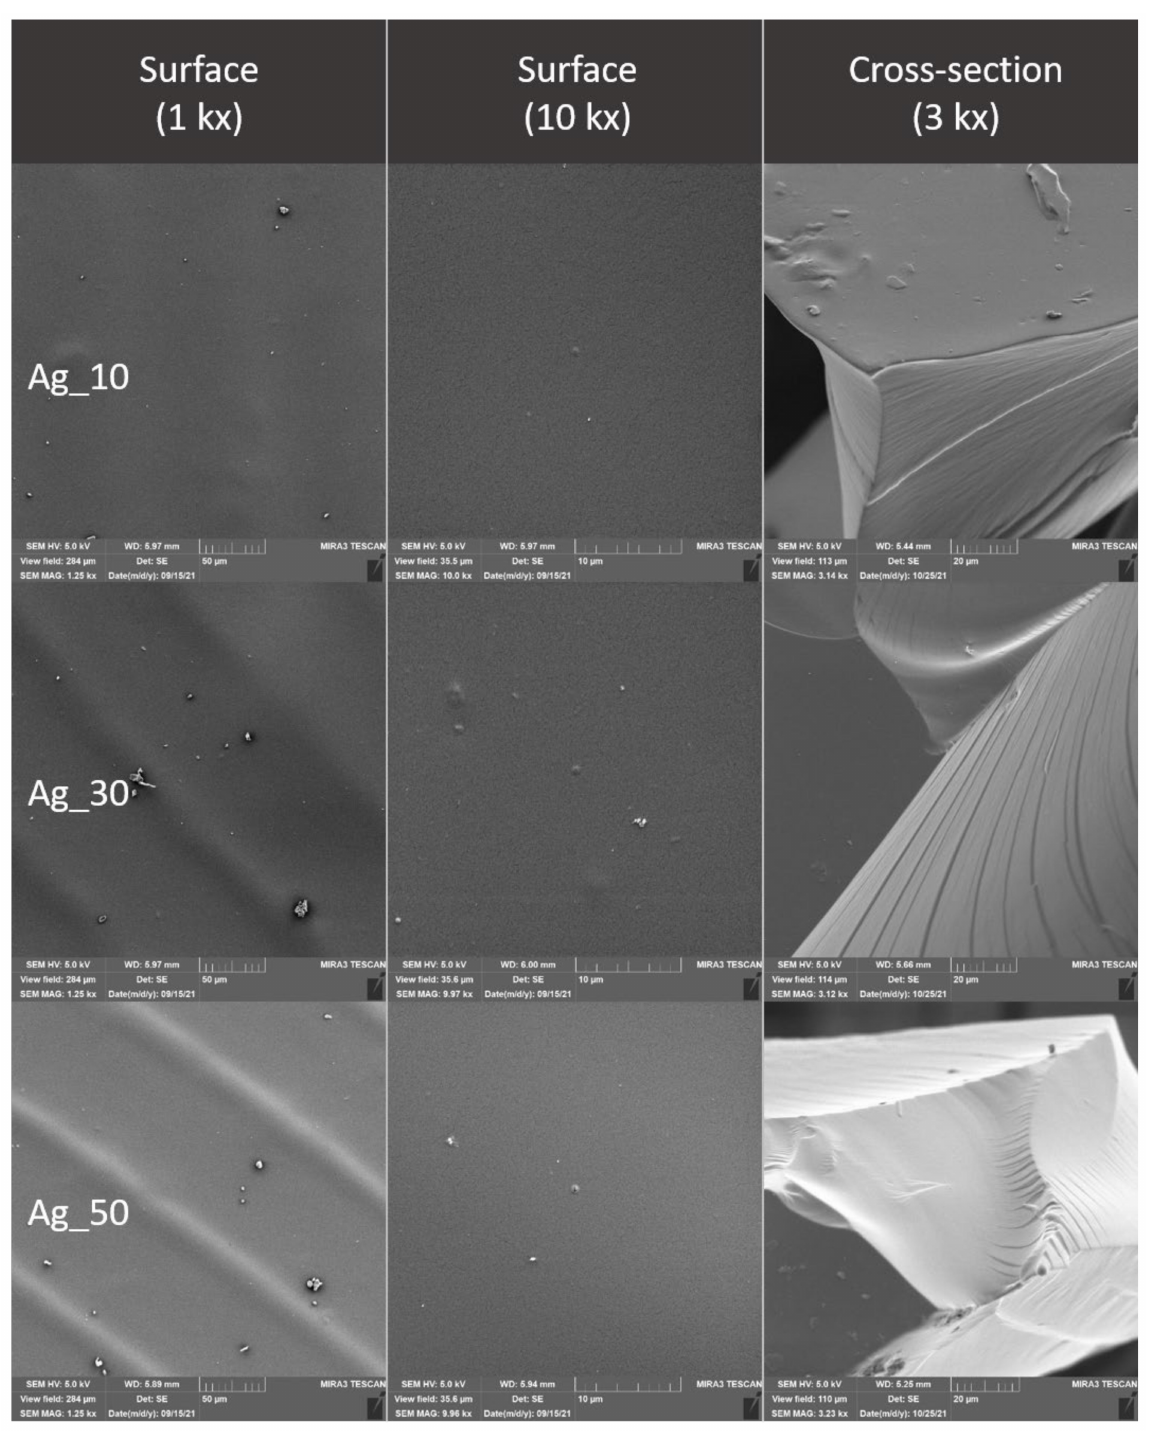
Figure 9. Surface and fracture microstructure of edible packaging with the addition of colloidal silver